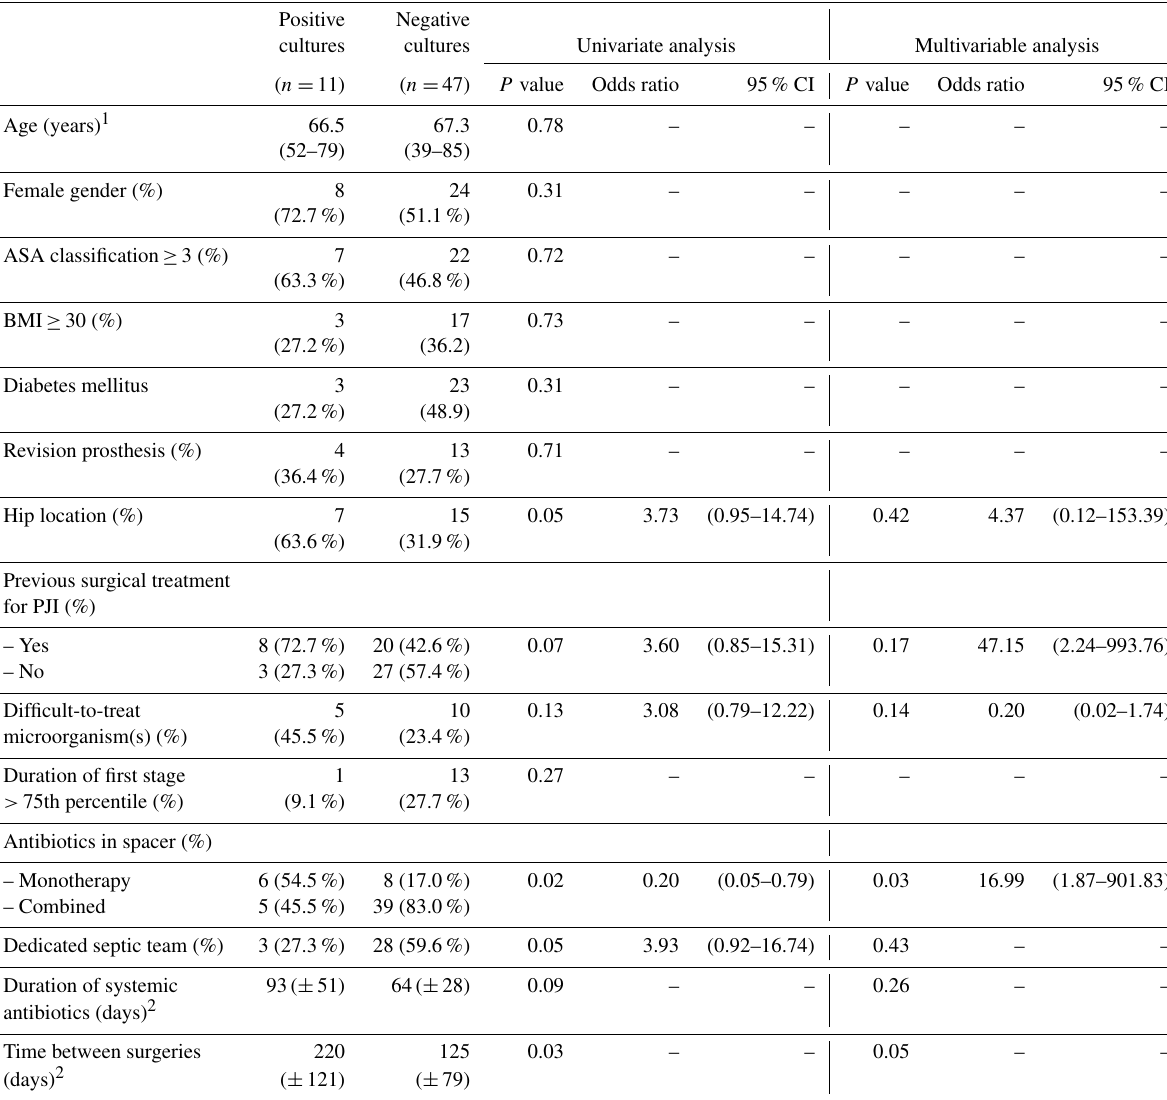
Table 3. Analysis of risk factors for positive cultures in the second stage in all